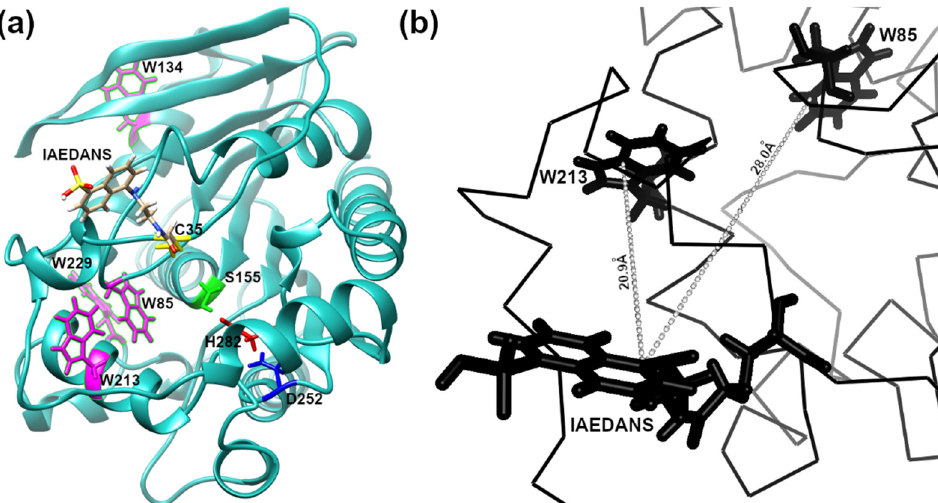
Figure 1. In silico representation of the 3D structure of the EST2-S35C: ( a ) ribbon representation showing in stick form: the catalytic triad Ser155 (green), Asp252 (blue) and His282 (red); the fluorescent probe IAEDANS; the tryptophan residues (magenta); ( b ) representation focusing on a part of the EST2-S35C backbone, highlighting the distance between the tryptophan residues 85 and 213.